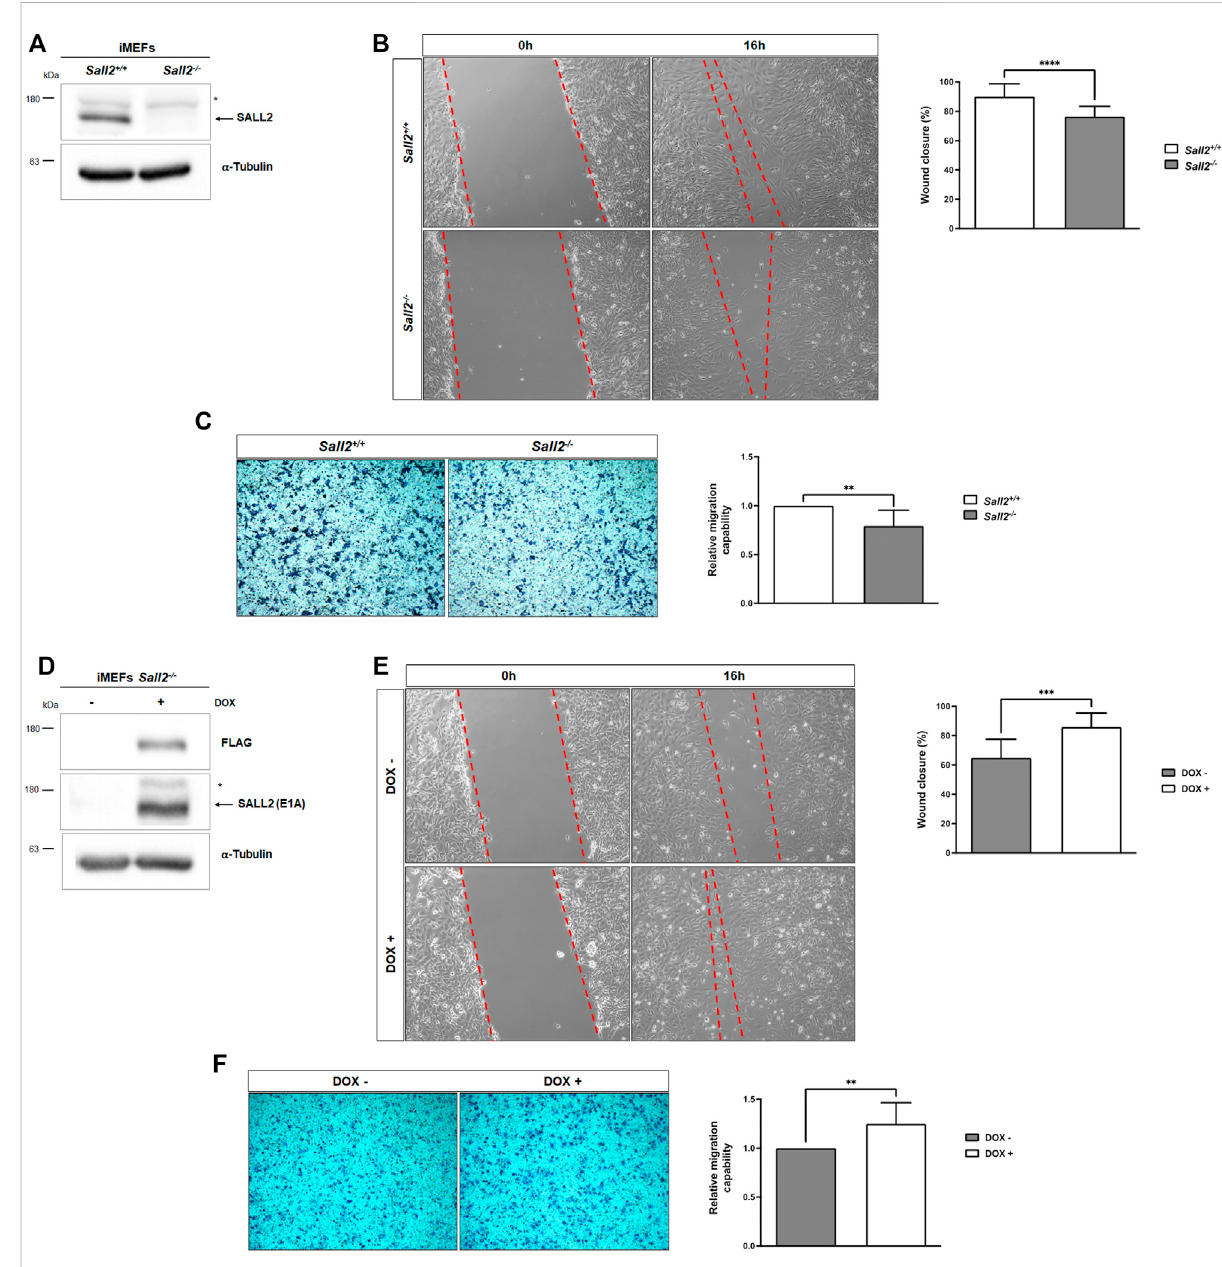
FIGURE 1 Sall2 promotes iMEFs migration. (A) Western blot analysis of endogenous Sall2 in Sall2 +/+ and Sall2 − / − iMEFs. The arrow indicates Sall2, and the asterisk corresponds to a nonspeci fi c band. α -tubulin was used as the loading control. (B) Left, representative phase-contrast images (10x) at 0 and 16 hof invitro woundingfrom Sall2 +/+ and Sall2 − / − iMEFs.Right,quanti fi cationofwoundclosure(asapercentage)at16 hfromimagesobtainedin (B) . (C) Left, representative microscopy images (10x) of transwell inserts from Sall2 +/+ and Sall2 − / − iMEFs after 4 h of cell migration. Right, quanti fi cation of the number of migrated cells from images obtained in (C) . (D) Western blot analysis of mSall2 E1A isoform (FLAG) expression in the Tet-On Sall2 iMEFs inducible model (doxycycline (1,000 ng/ml, 48 h). (E) Left, representative phase-contrast images (10x) at 0 and 16 h of in vitro wounding from the Tet-On Sall2 iMEFs. Right, quanti fi cation of wound closure (as a percentage) at 16 h from images obtained in (E) . (F) Left, representativemicroscopyimages(10x)oftranswellinsertsfromtheTet-OnSall2iMEFsmodelafter 4 hofcellmigration. Right,quanti fi cationofthe number of migrated cells from images obtained in (F) . Data is expressed as mean ± SD from three independent experiments performed in quintuplicate and triplicated, respectively (** p = 0.001 to 0.01, *** p = 0.0001 to 0.001, **** p ≤ 0.0001; unpaired t